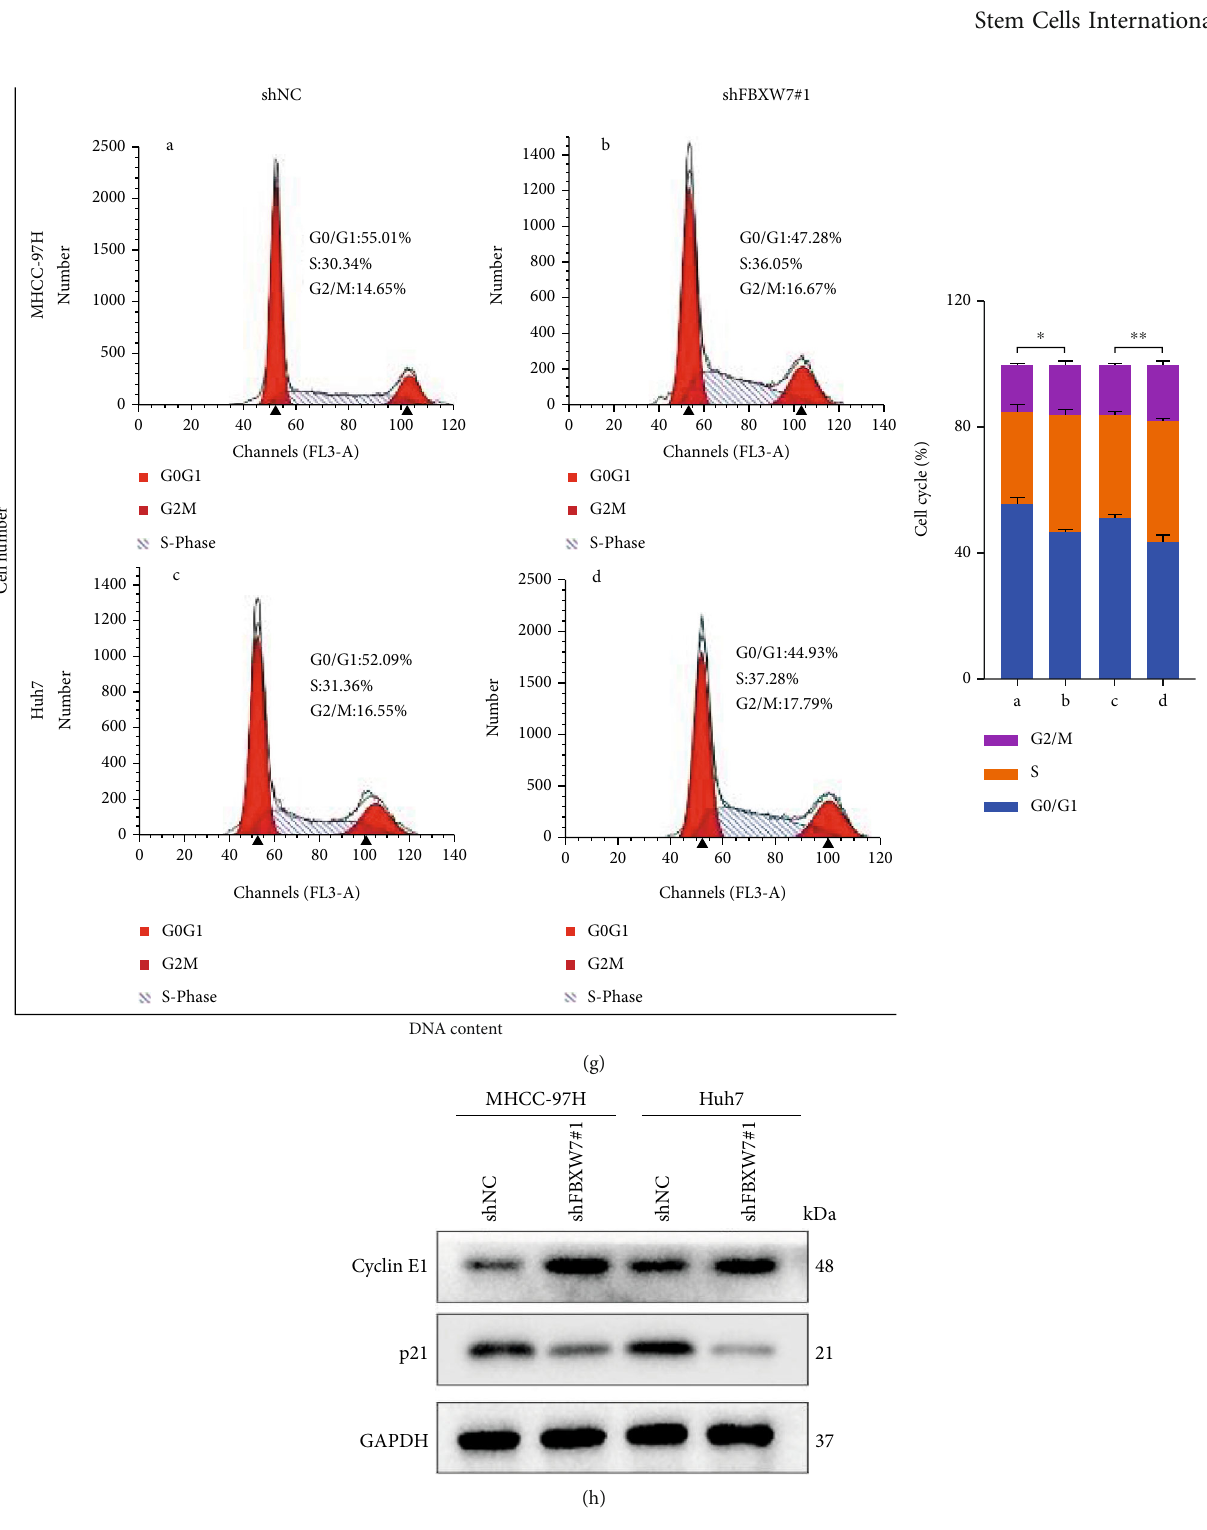
Figure 2: FBXW7 downregulation promotes the stem cell-like properties of HCC cells. (a) RT-qPCR and Western blot analysis of mRNA and protein level of FBXW7 in the cell lines infected with LV-shFBXW7#1, #2, and shNC. (c – h) The experimental method is the same as Figure 1. Graph represents mean ± SD ; ∗ P < 0 : 05 , ∗∗ P < 0 : 01 , ∗∗∗ P < 0 : 001